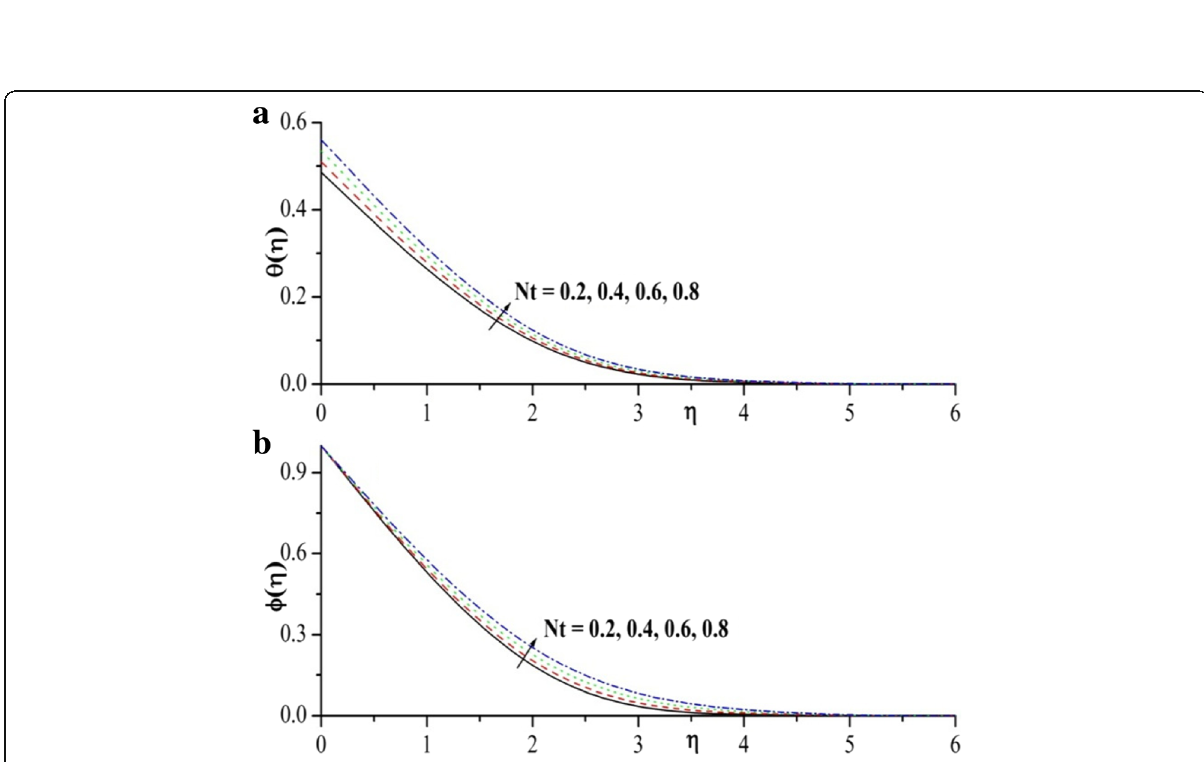
Fig. 17 a Temperature and b nanoparticle concentration profiles for variable values of